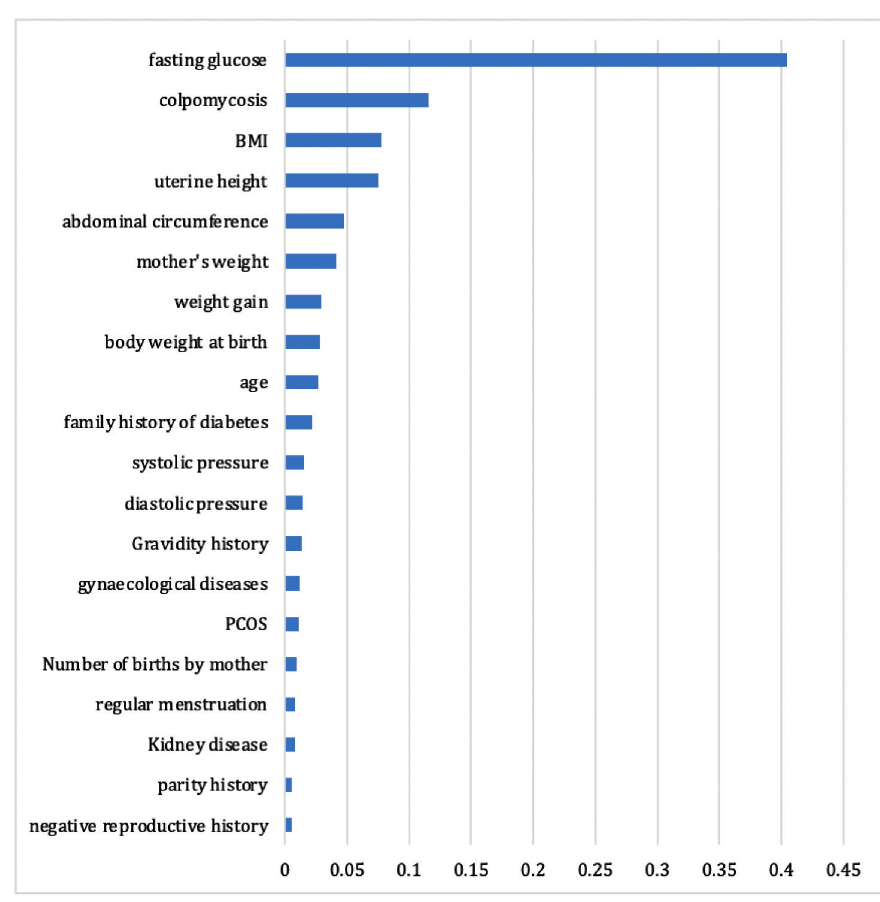
Figure 6. Weighted ranking in the F2 model (top